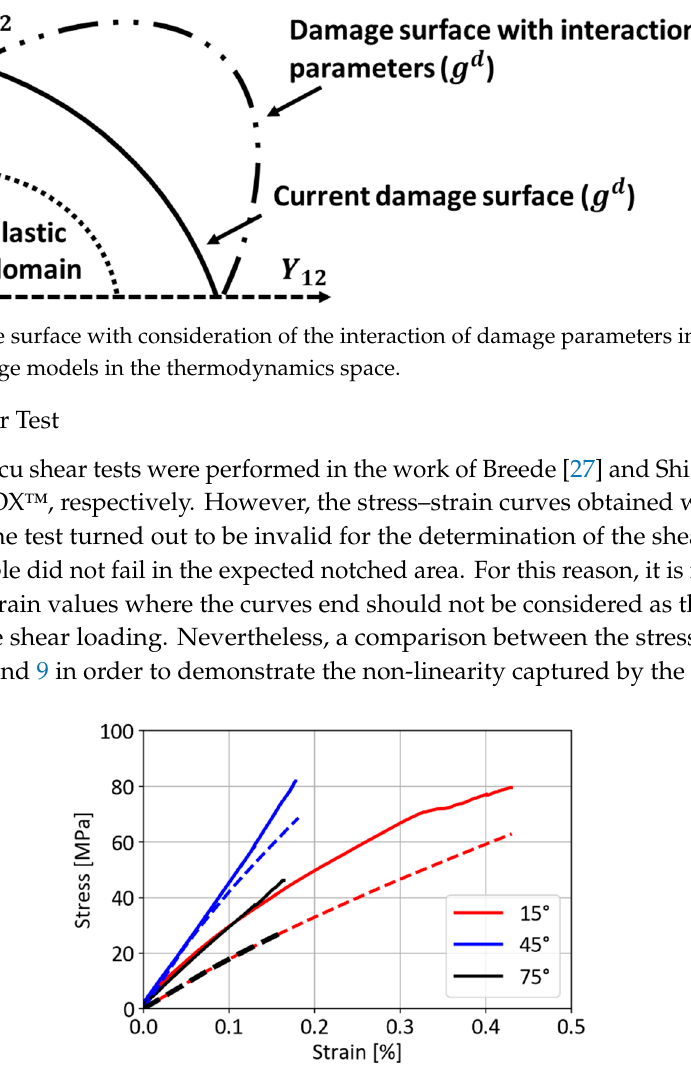
Figure 6. Comparison between damage curves obtained from experiments (solid line) and simulation (broken line) for C/C–SiC.